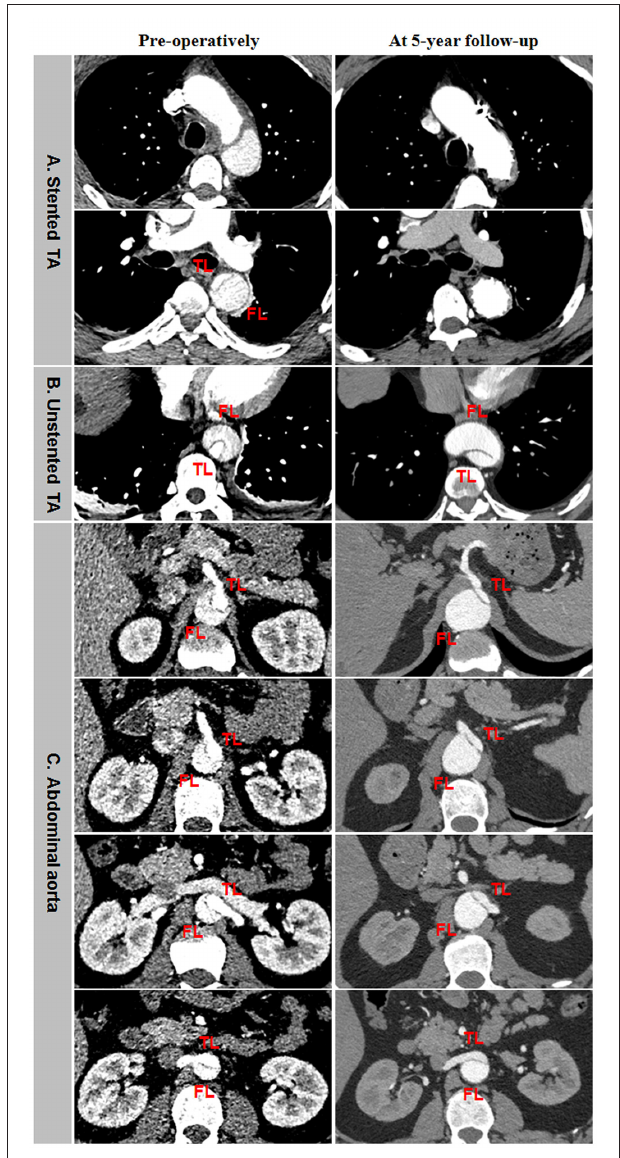
FIGURE 6 | Abdominal aneurismal expansion during a long-term follow-up after TEVAR for TBAD. (A) FL was completely thrombosed and obliterated on the stented thoracic aorta during a 5-year follow-up. (B) The persistent patency and obvious enlargement of FL occurred on the unstented thoracic aorta in a 5-years post-operation. (C) Aneurysmal degeneration of the distal abdominal aorta was attributed to TL shrinkage and FL expansion in 5 years after TEVAR. TBAD, type B aortic dissection; TEVAR, thoracic endovascular aortic repair; FL, false lumen; TL, true lumen.